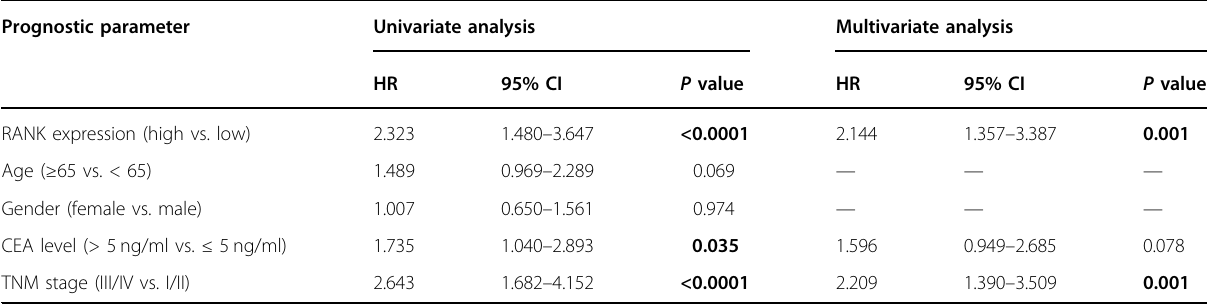
Table 2 Univariate and multivariate analyses of prognostic parameters for overall survival in 203 CRC patients.